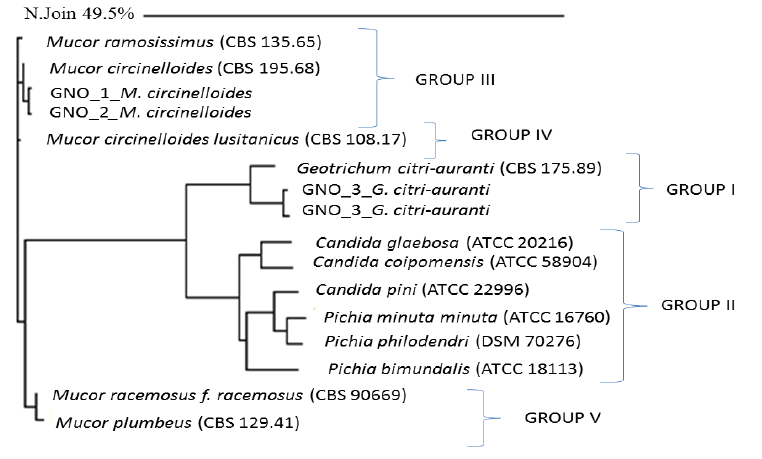
Figure 9. Neighbor-Joining phylogenetic tree showing the relationships between fungi isolated from municipal sewage sludge and related fungi in the MicroSeq database based on the sequences of the D2 LSU region of nuclear